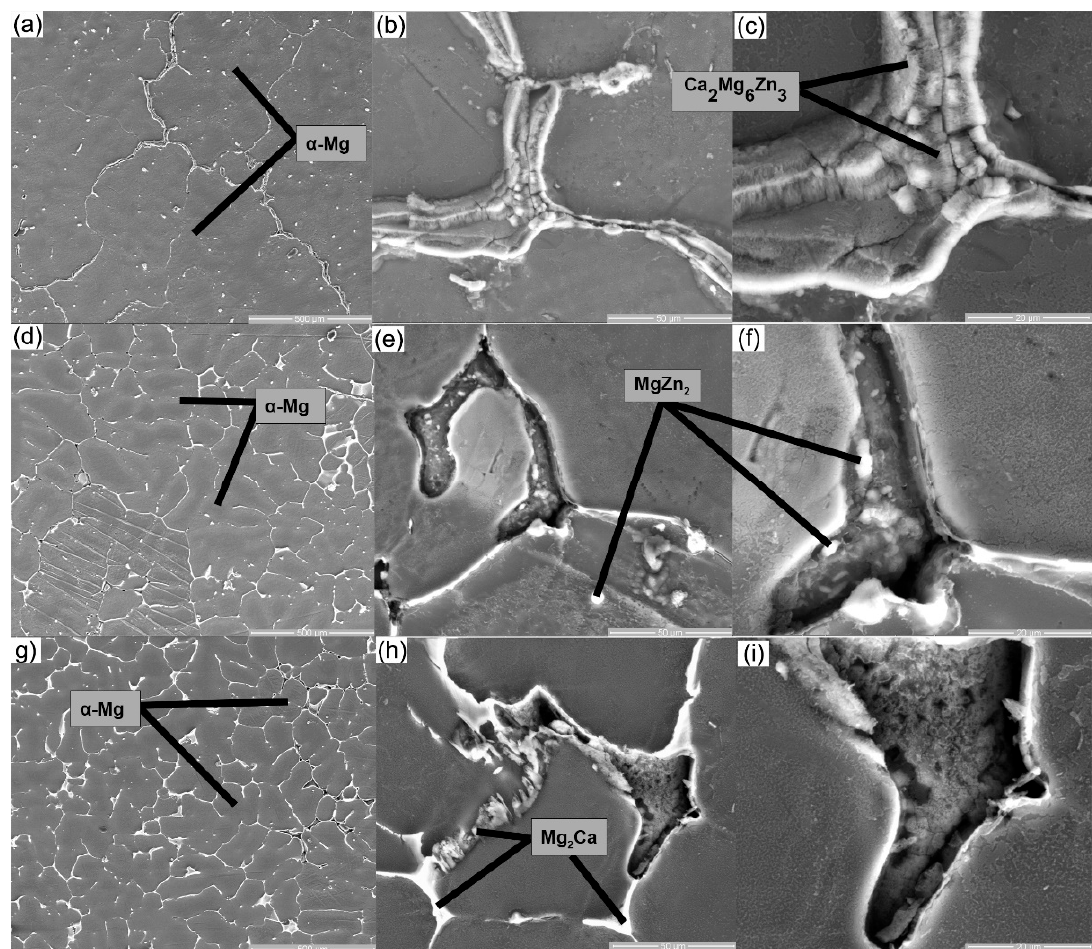
Figure 2. SEM images of the Mg–0.5Ca–xZn samples: ( a – c ): x = 0.5 wt.% Zn; ( d – f ): x= 1.5 wt.% Zn; ( g – i ): x= 3 wt.% Zn.